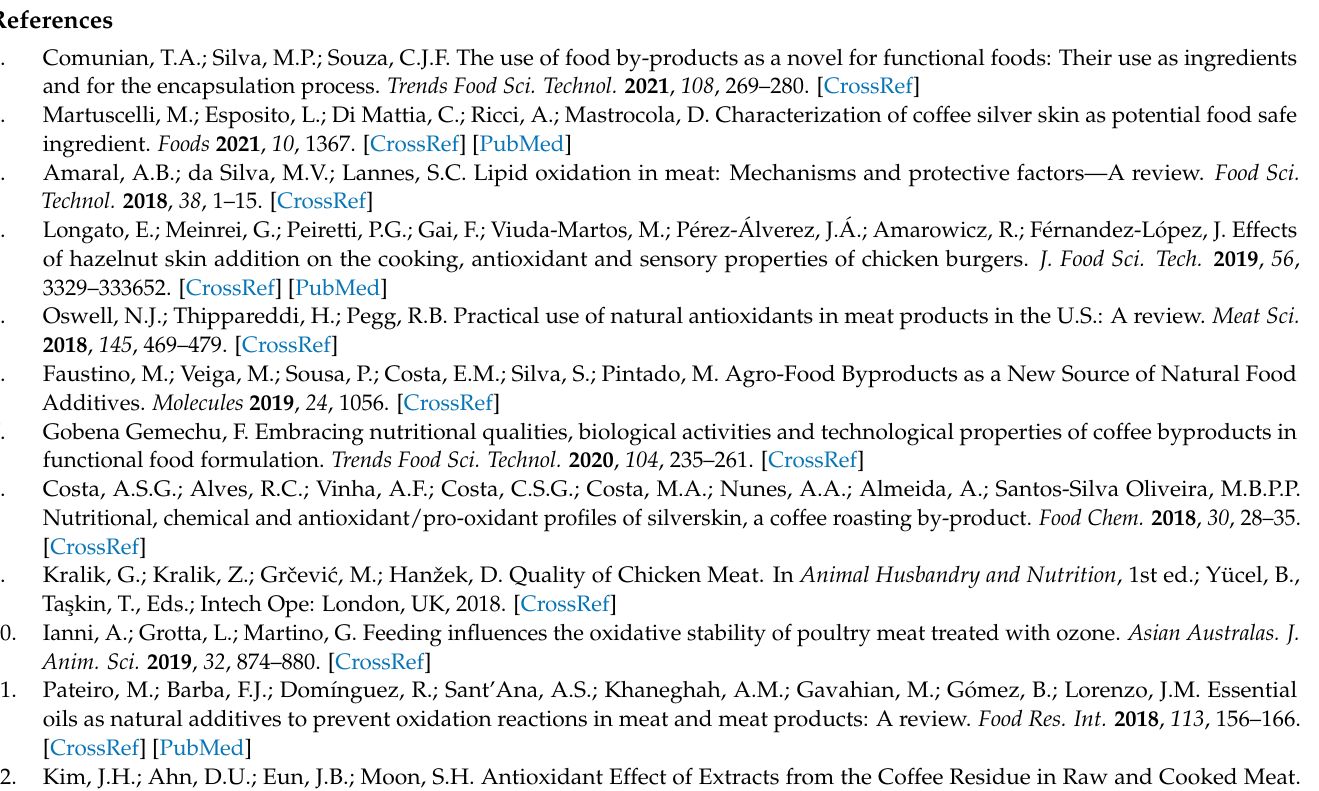
Figure S2: Chromatogram of volatile compounds (VOCs) in chicken burgers formulated with CSS 1.5%, immediately after cooking (a) and after 72 h of refrigerated storage (b); Figure S3: Chro- matogram of volatile compounds (VOCs) in chicken burgers formulated with CSS 3%, immediately after cooking (a) and after 72 h of refrigerated storage